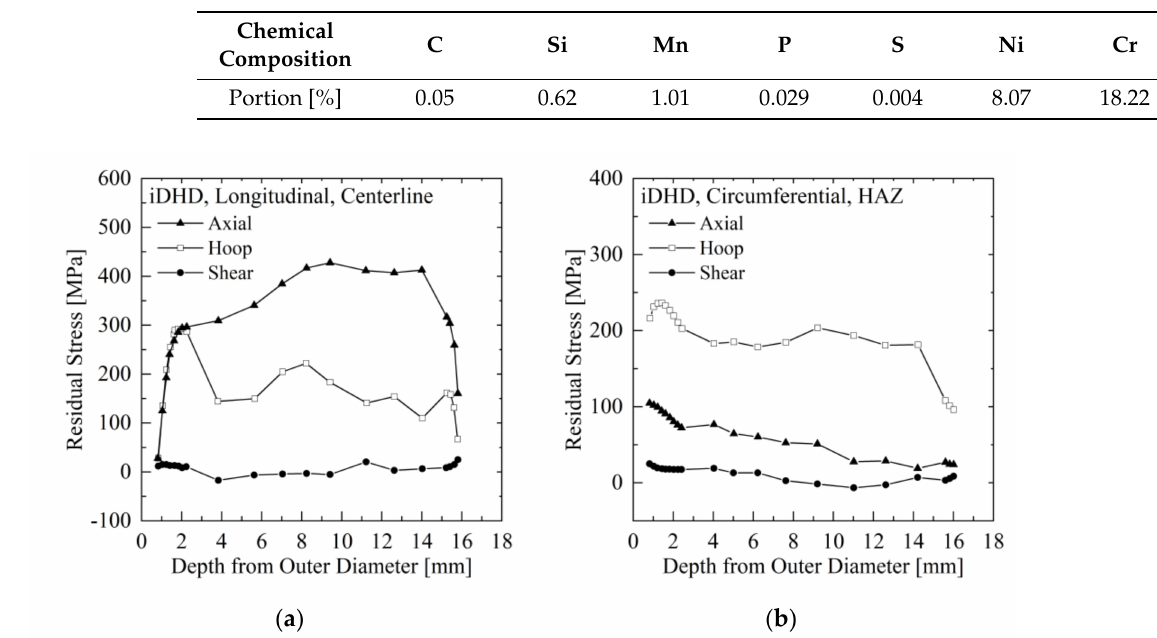
Figure 1. Residual stresses measured in the full-scale mock-up canister test [2]: ( a ) longitudinal direction in the centerline and ( b ) circumferential direction in the HAZ.